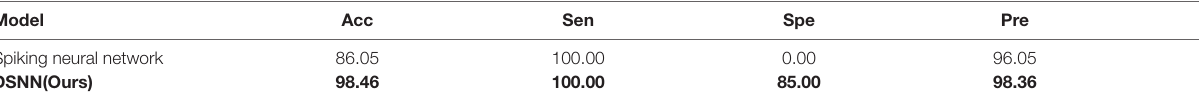
TABLE 7 | The final result of the spiking neural network (unit: %).